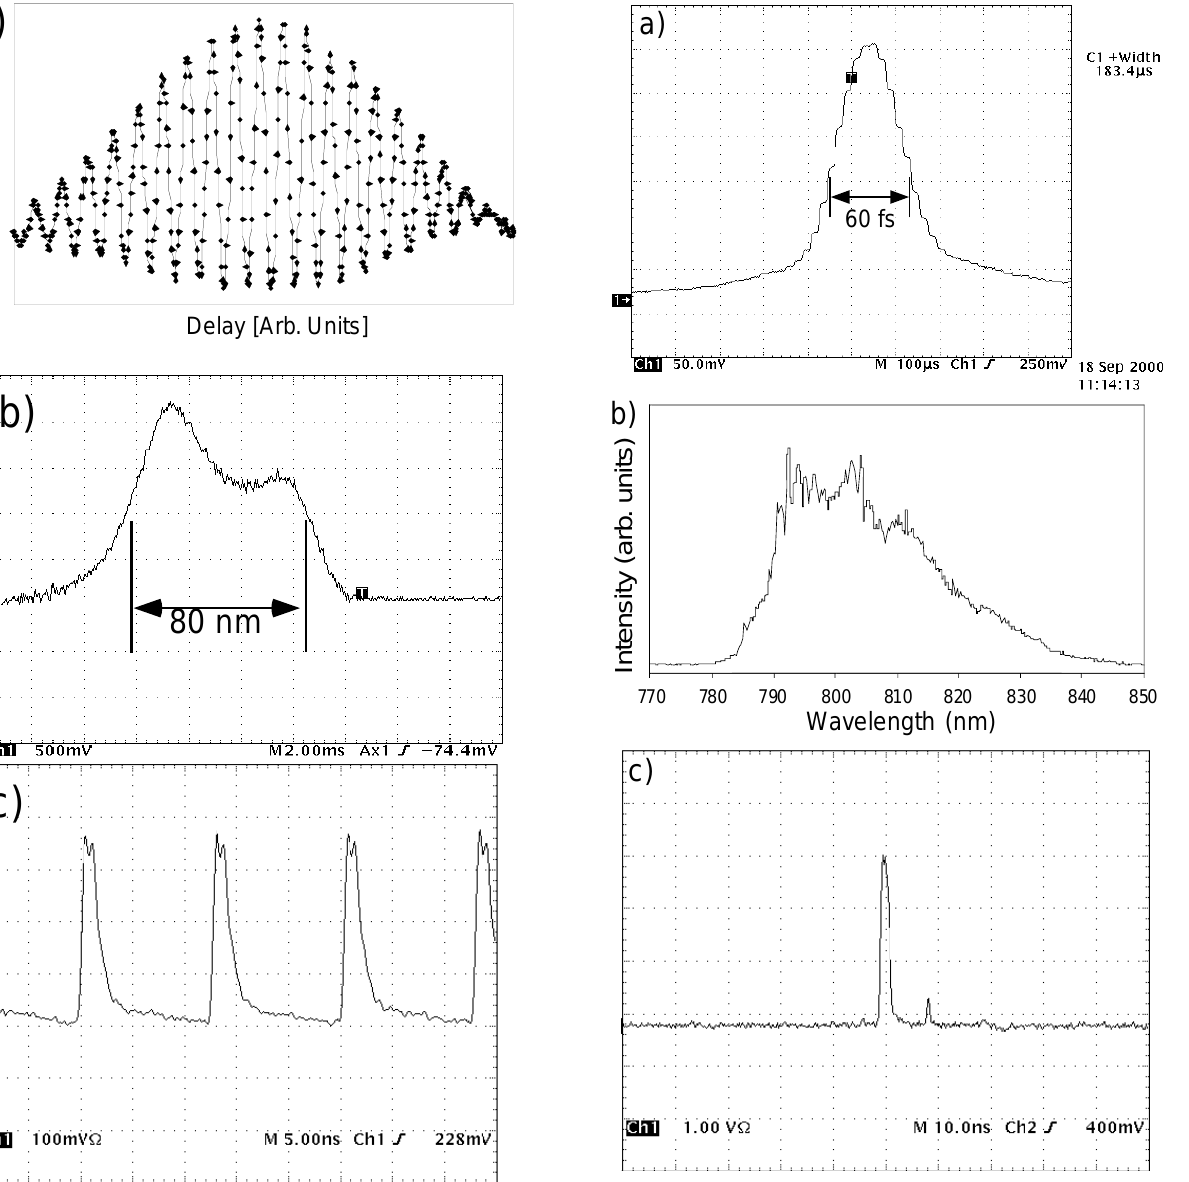
FIG. 8. (a) Autocorrelation trace, (b) spectrum, and (c) tem- poral profile as measured on photodiode of one pulse as it exits the regenerative amplifier ( 10 ns (cid:1)